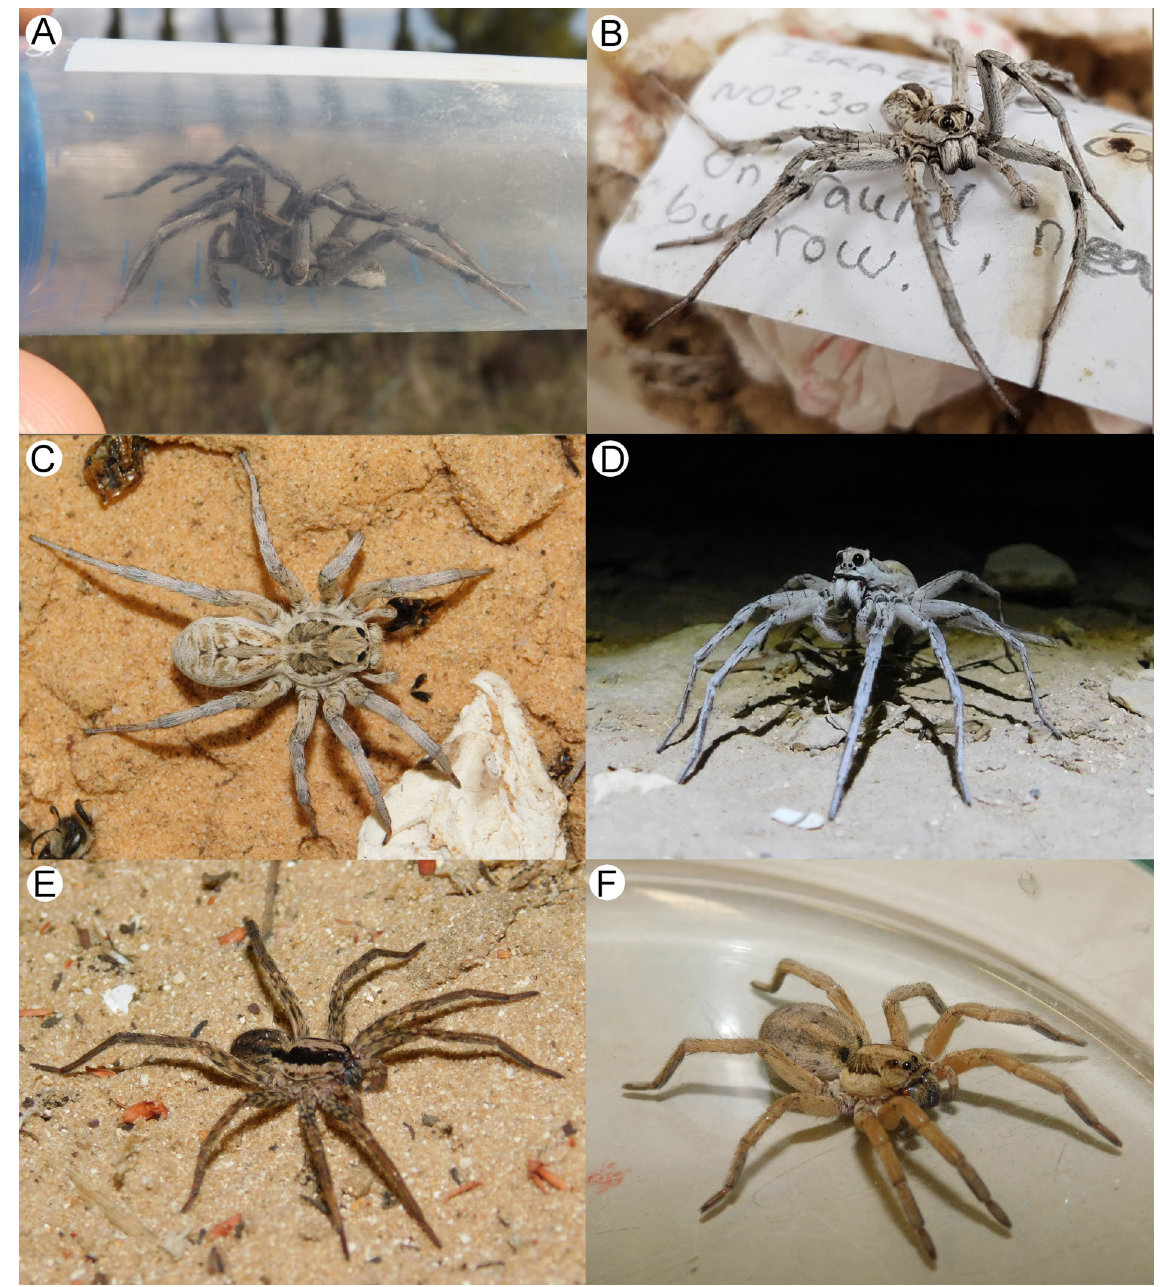
Fig. 8. Live specimens. A . Geolycosa vultuosa C.L. Koch, 1838. B . Lycosa gesserit sp. nov., holotype, ♂ (HUJ INV-AR20631) C . Lycosa hyraculus sp. nov . , juveniles. D . Lycosa hyraculus sp. nov . , ♂ (specimen not collected ) . E . Hogna (cf . ) graeca (specimen not collected ) . F . Hogna effera (O. Pickard- Cambridge, 1872). Photos by I. Armiach